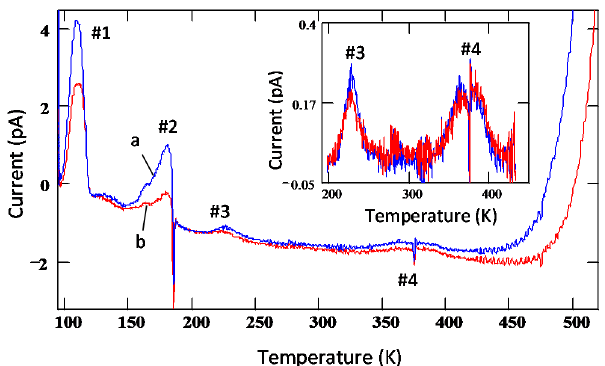
Figure 17. Thermally stimulated current (TSC) spectra obtained using an n-type 4H-SiC (n-M50)